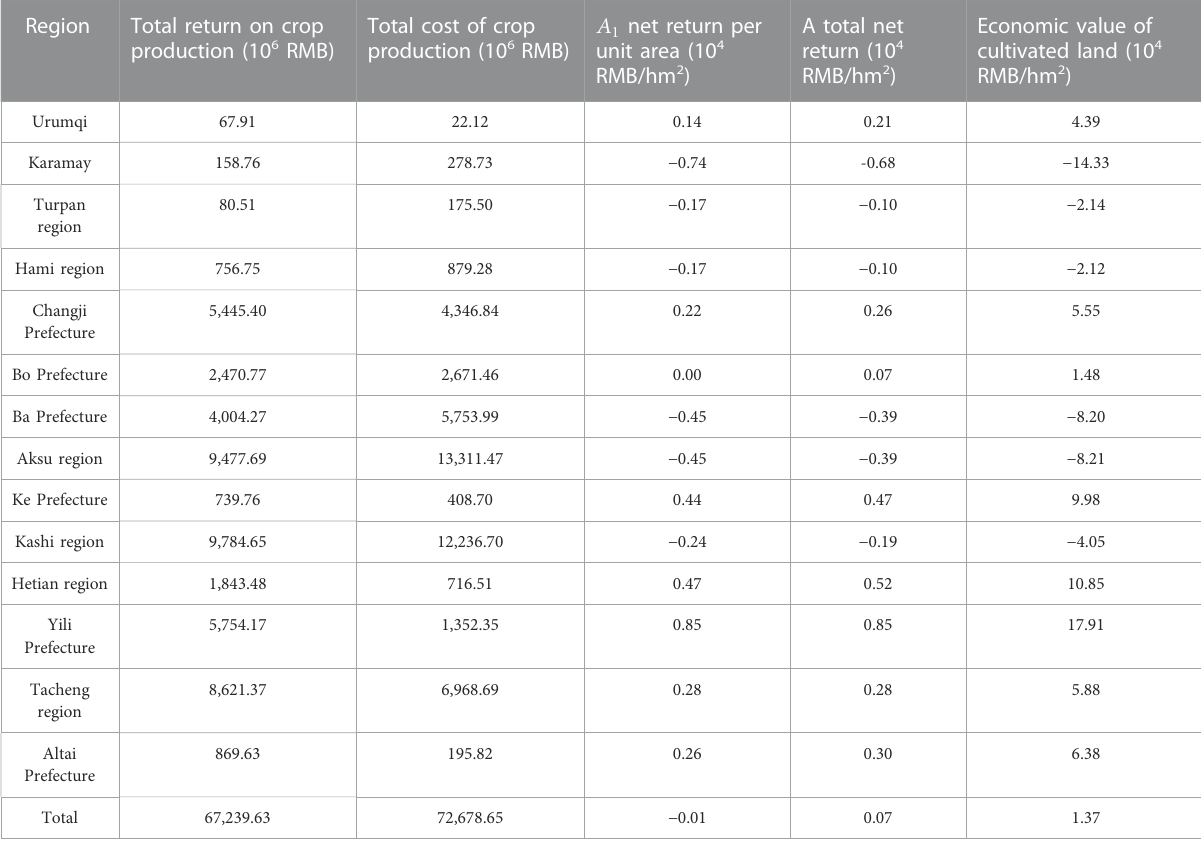
TABLE 3 Economic value of the cultivated land in the state (city).